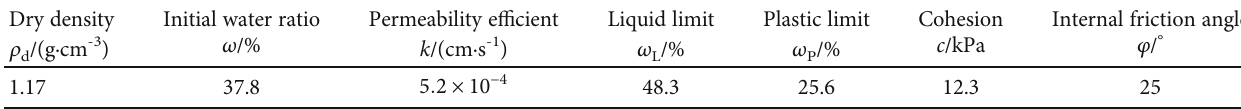
Table 1: Basic physical parameters of muddy fi llings of F2 fault.